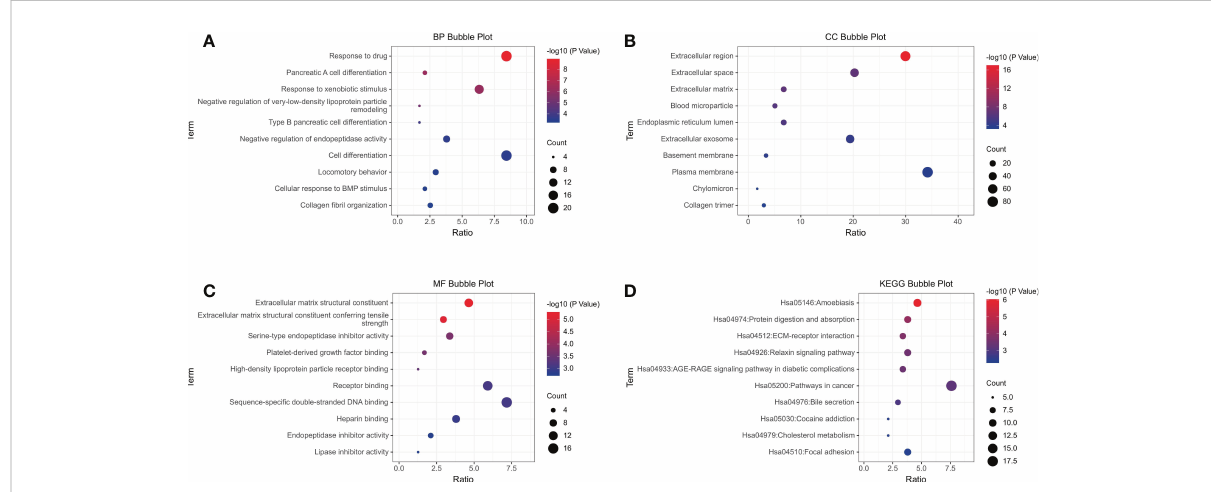
FIGURE 2 GO function and KEGG pathway analysis of 282 common DEGs. Analysis of (A) Biological Process, (B) Cellular Component, and (C) Molecular Function. (D) KEGG analysis showed the enriched pathways. Each functional section shows 10 terms.